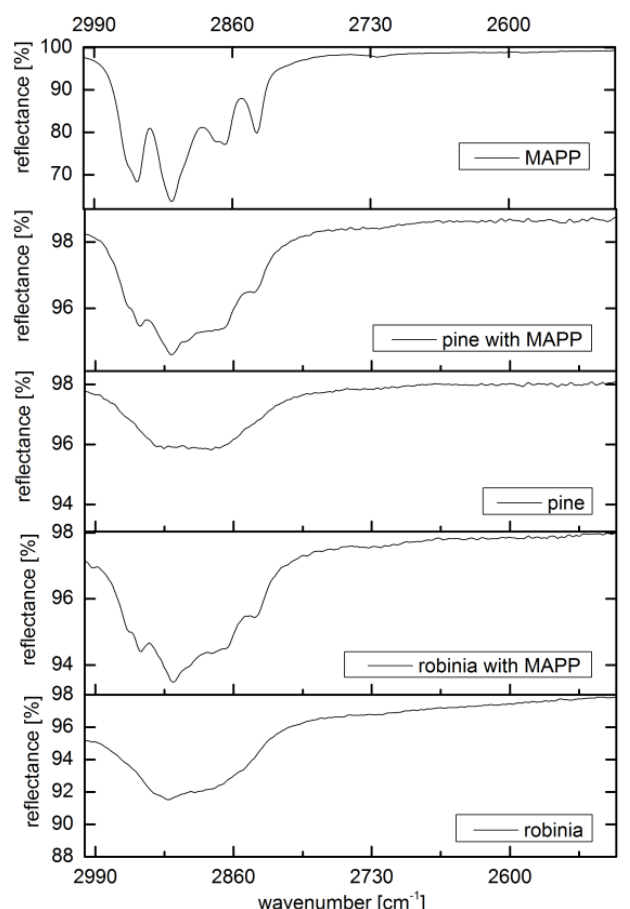
Figure 11. ATR-FTIR spectra of treated and untreated fibres as well as of the emulsified, freeze- dried MAPP.